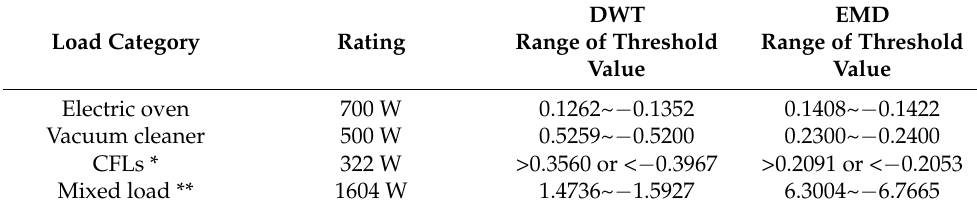
Table 1. Parameters of different load categories used in testing.